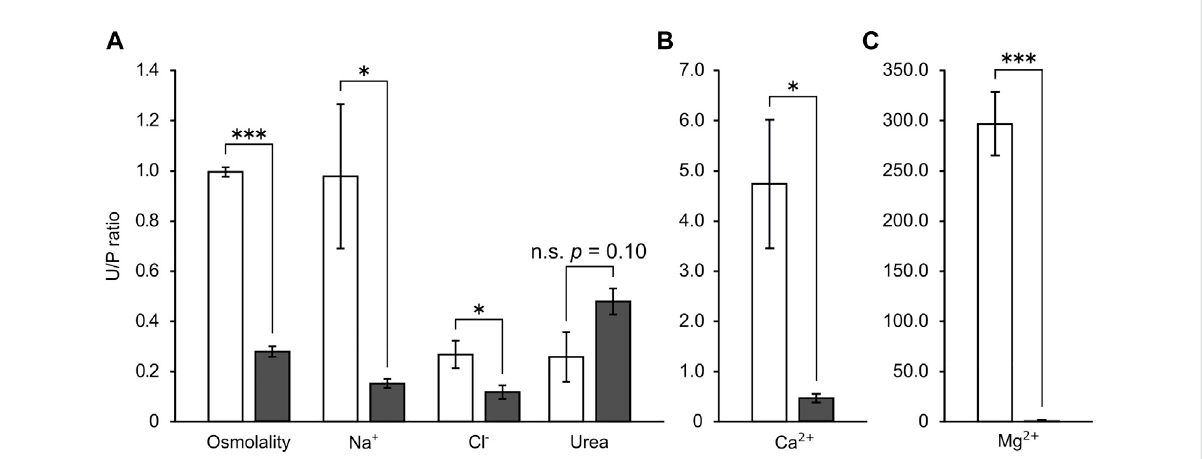
FIGURE 1 The urine/plasma (U/P) ratios of major osmolytes (A) and divalent ions (B,C) in the stingray. Open and fi lled bar represent values from SW- and 5% SW-acclimated stingrays, respectively. Asterisks indicate statistically signi fi cant differences between SW- and 5% SW-acclimated stingrays (* p < 0.05, *** p <